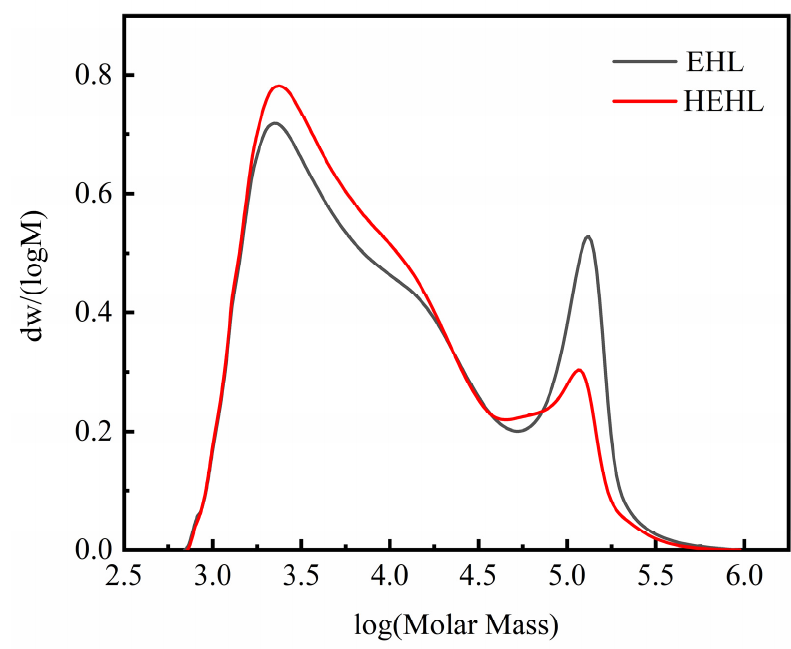
Table 2. Gel permeation analysis for EHL and HEHL .